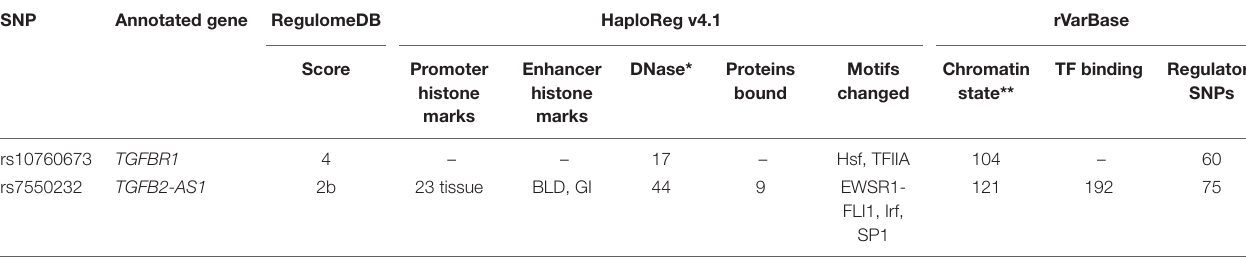
TABLE 8 | Functional annotation obtained using RegulomeDB, HaploReg, and rVarBase. SNP Annotated gene